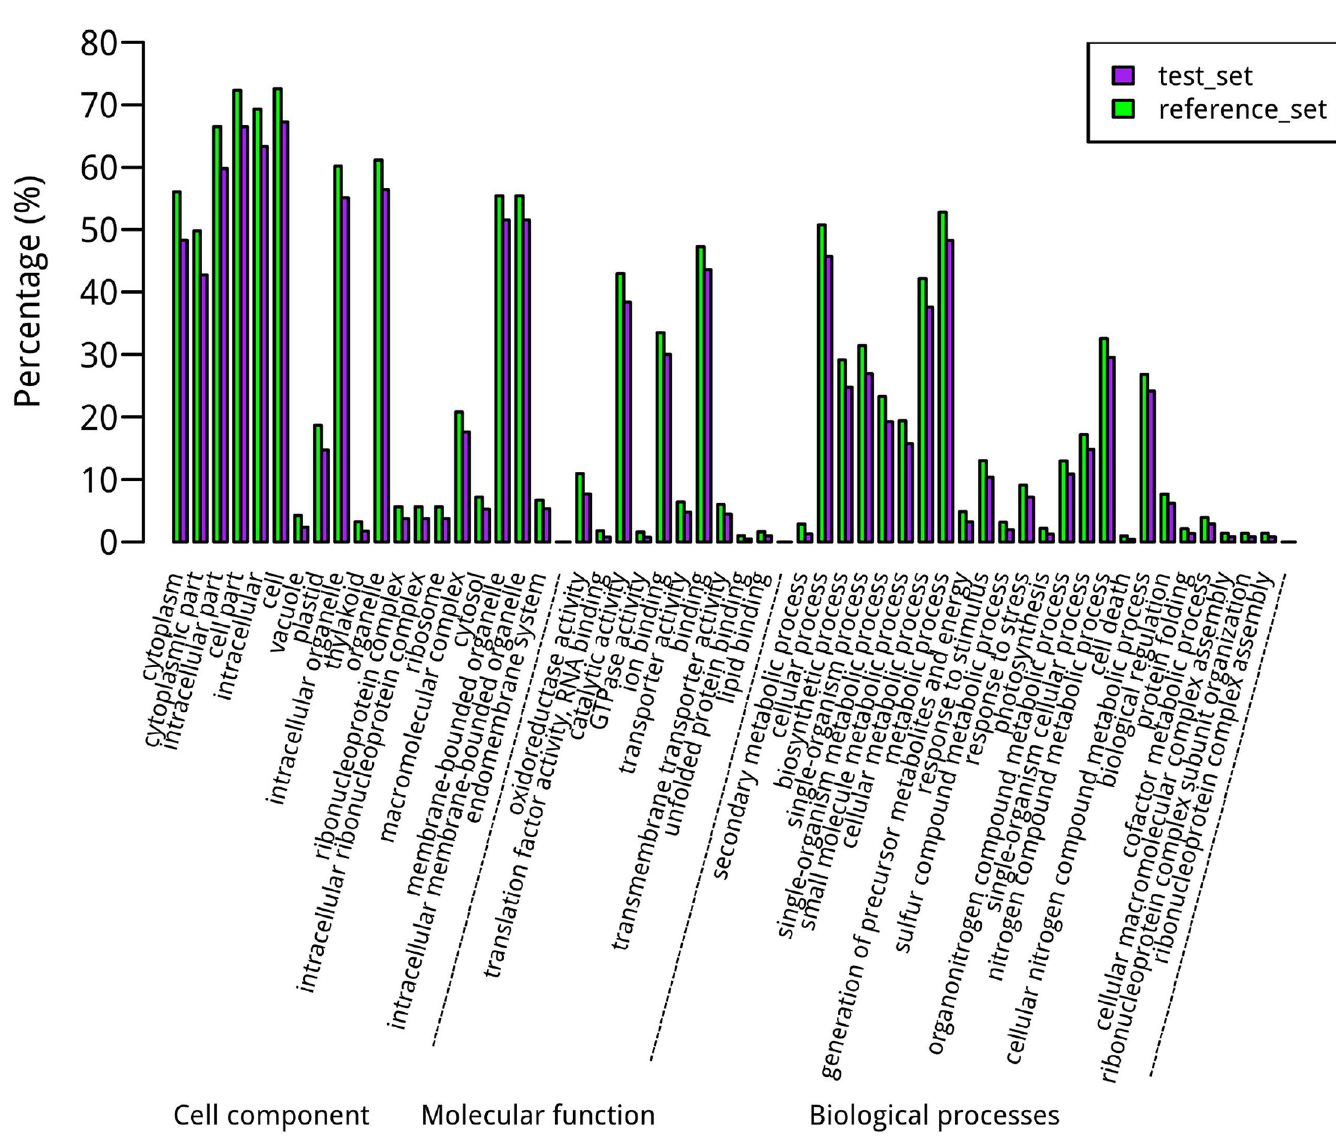
Fig 6. Enrichment analysis for the function of circRNAs as miRNA decoys. The GO terms containing BP (biological processes), MF (molecular functions) and CC (cell components). The GO annotation is presented on the x-axis legend and the percentage of genes on the y-axis legend (Fisher’s test, FDR < 0.05).